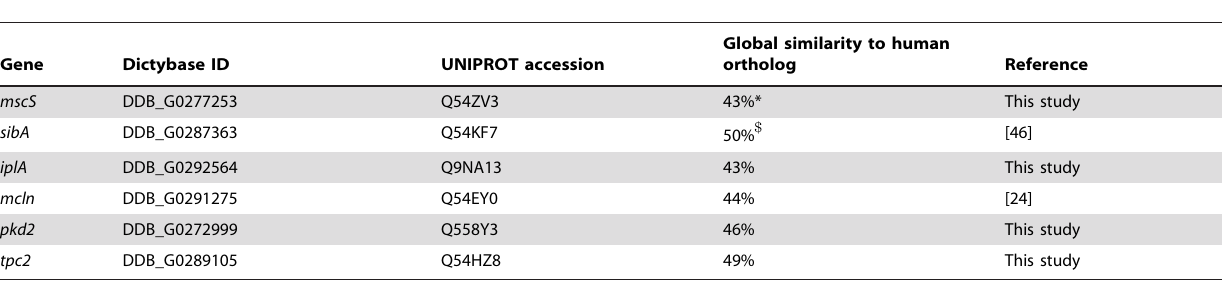
Table 1. Dictyostelium orthologs with a potential role in mechanosensing.